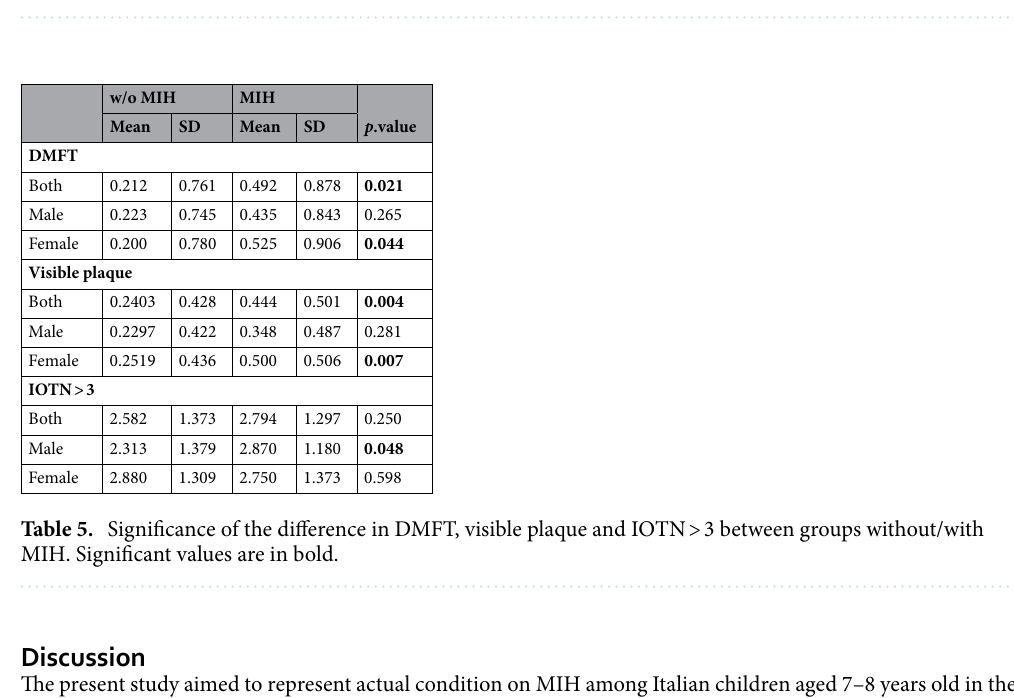
Table 4. Logistic model results for probability of MIH.